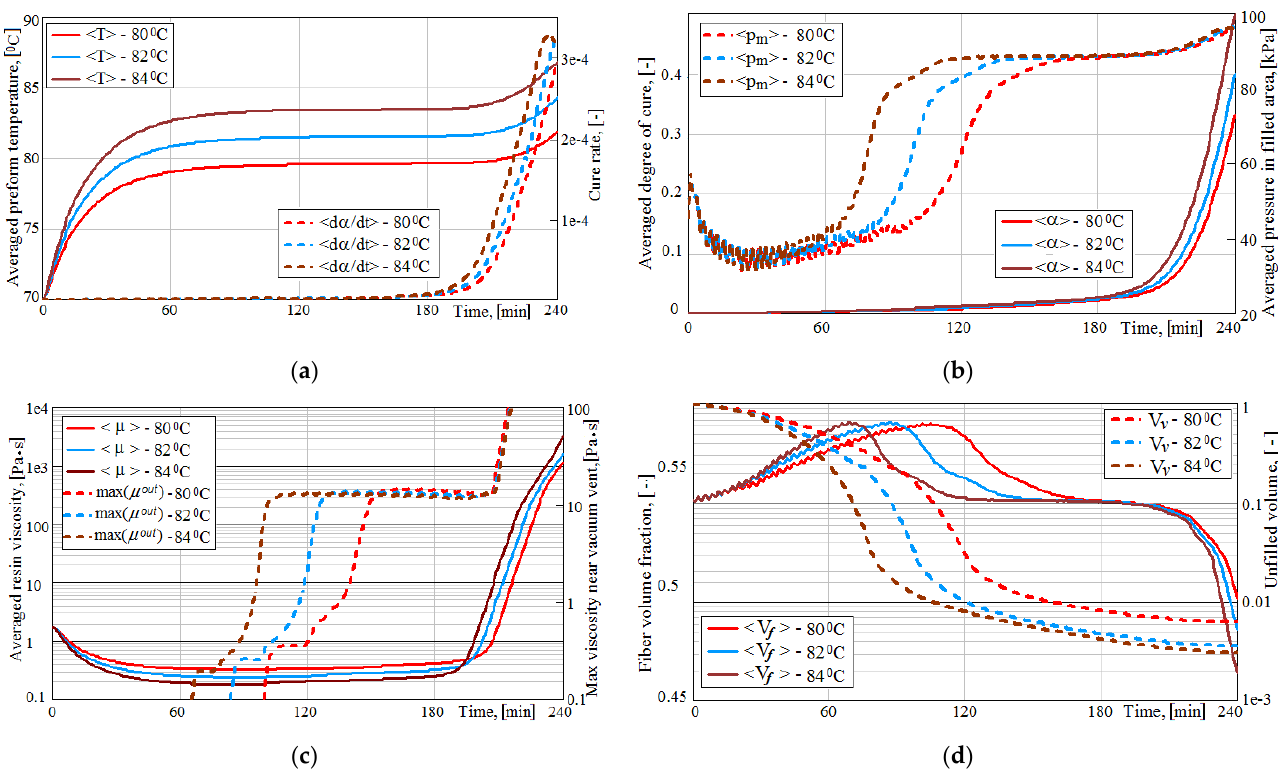
Figure 3. Superimposed time dependences of some process parameters: ( a ) Average temperatures < T > and resin cure rate < d α /dt >; ( b ) Average pressures < p m > and degree of cure < α >; ( c ) Average viscosity < µ > and maximum resin viscosity max( µ out ) in the vicinity of the vacuum outlet; ( d ) Average fiber volume fraction < V f > and relative void volume V v.